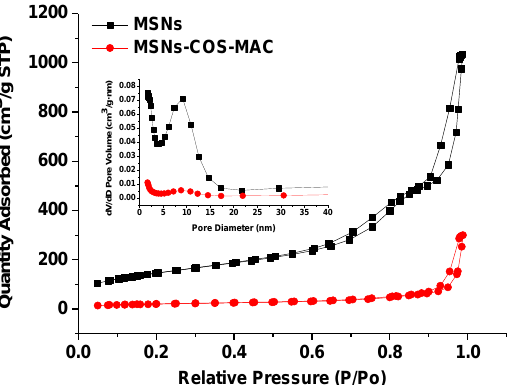
Figure 1. TEM photographs of MSNs ( A ), MSNs-COS ( B ) and MSNs-COS-MAC ( C ). ( D ) MSNs- COS-MAC dispersed in a pH 1.0 hydrochloric acid solution for one hour. ( E ) MSNs-COS-MAC dis- persed in distilled water for one hour.